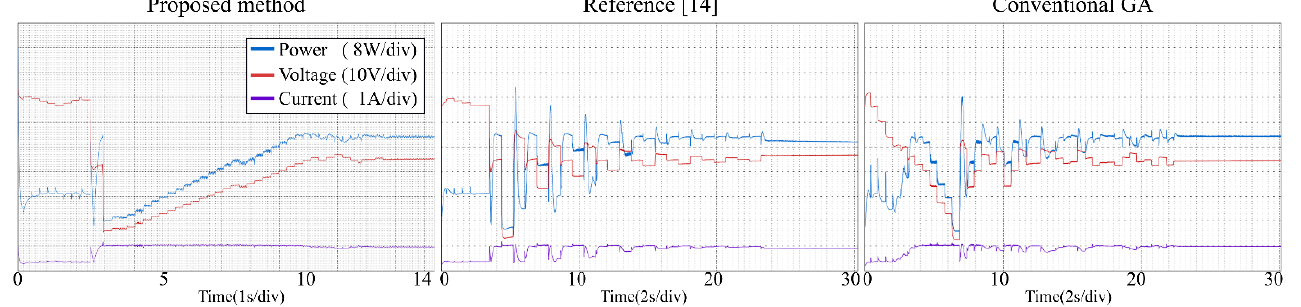
Figure 13. Tracking process—Pattern 1.